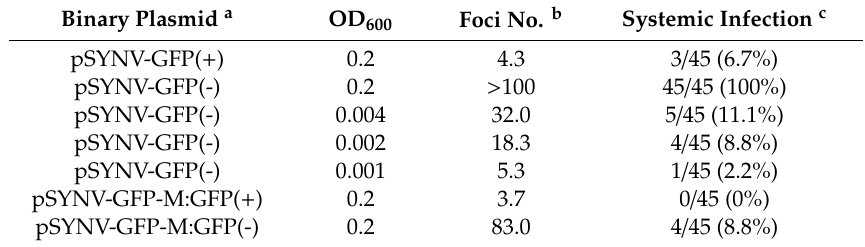
Table 1. Comparison of rescue e ffi ciency of SYNV derivatives from antigenomic and genomic cDNA clones in N.